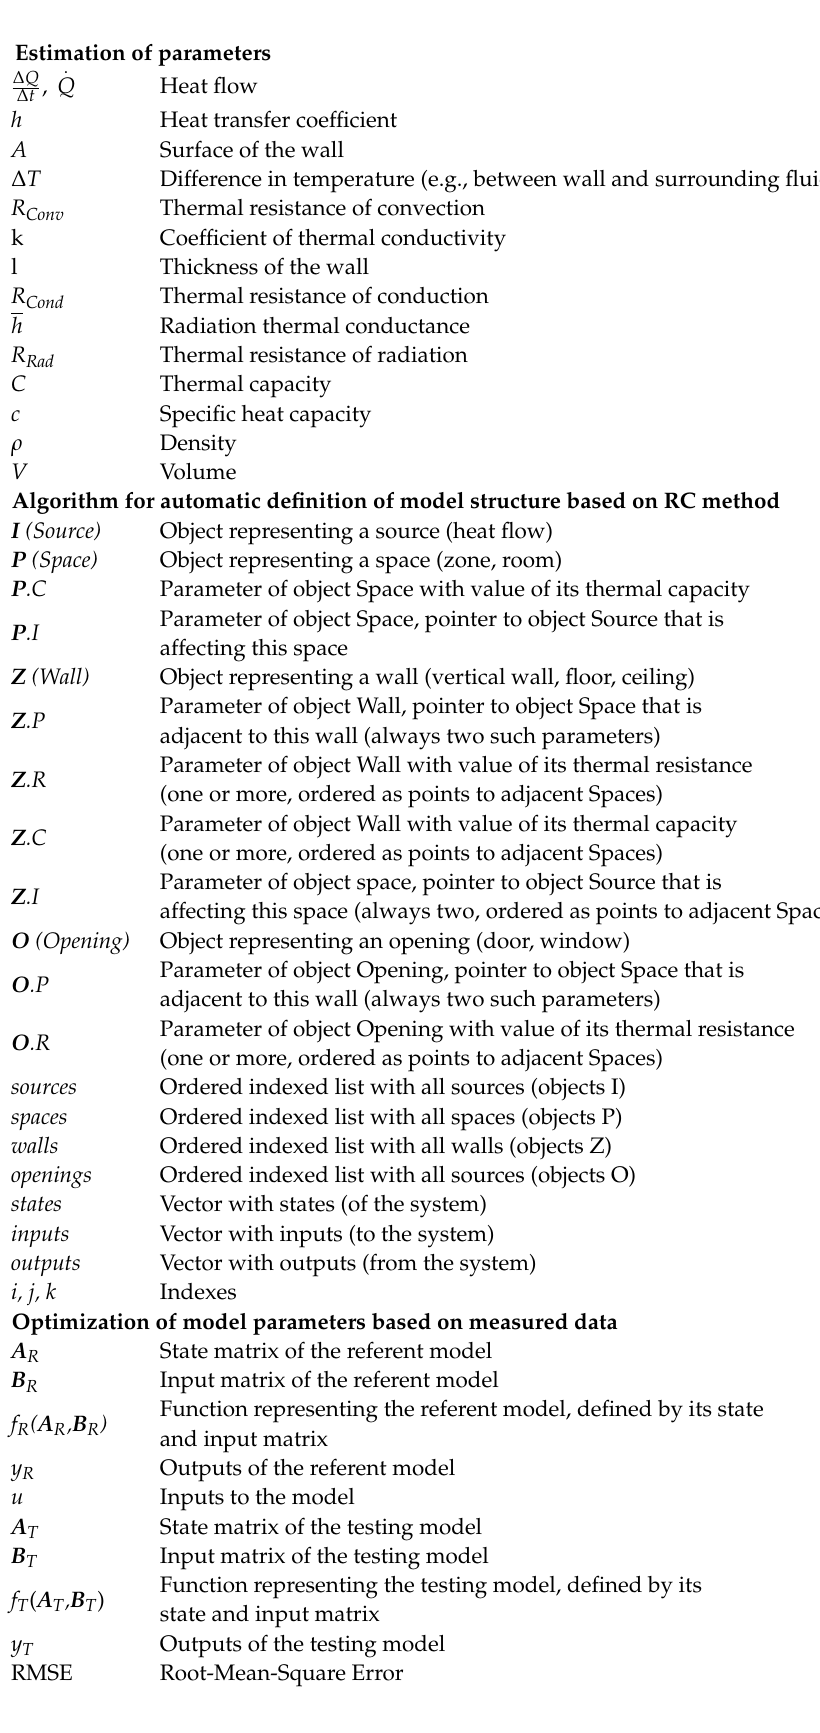
Algorithm for automatic definition of model structure based on RC